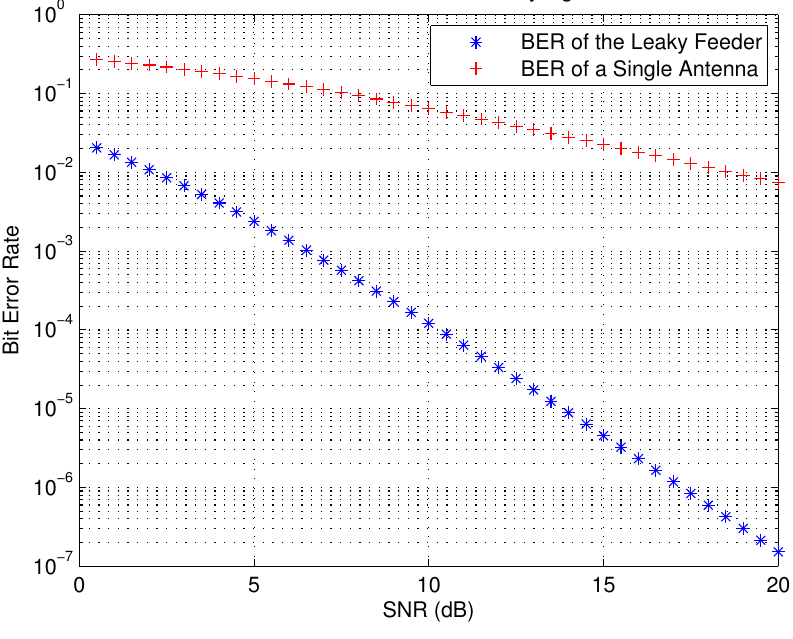
Figure 5. BER of Leaky Feeder with phase